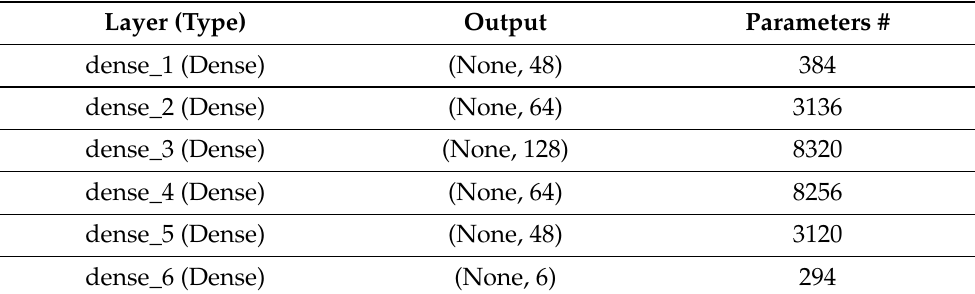
Table 7. Structure of the ANN for model number 4 of DRL.